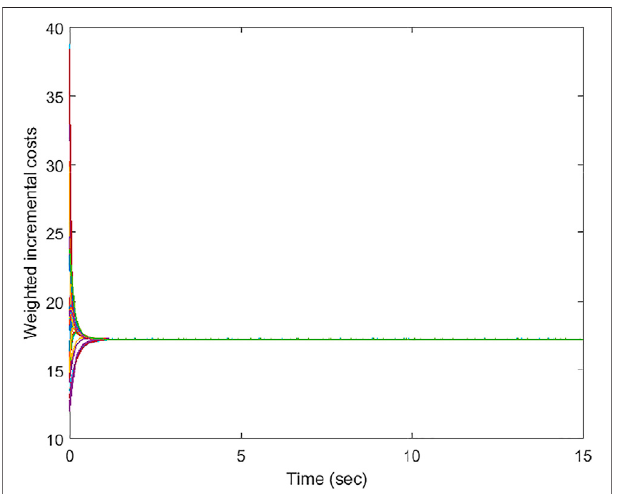
FIGURE 9 | Total generation under unity weights for IEEE-118 bus system.